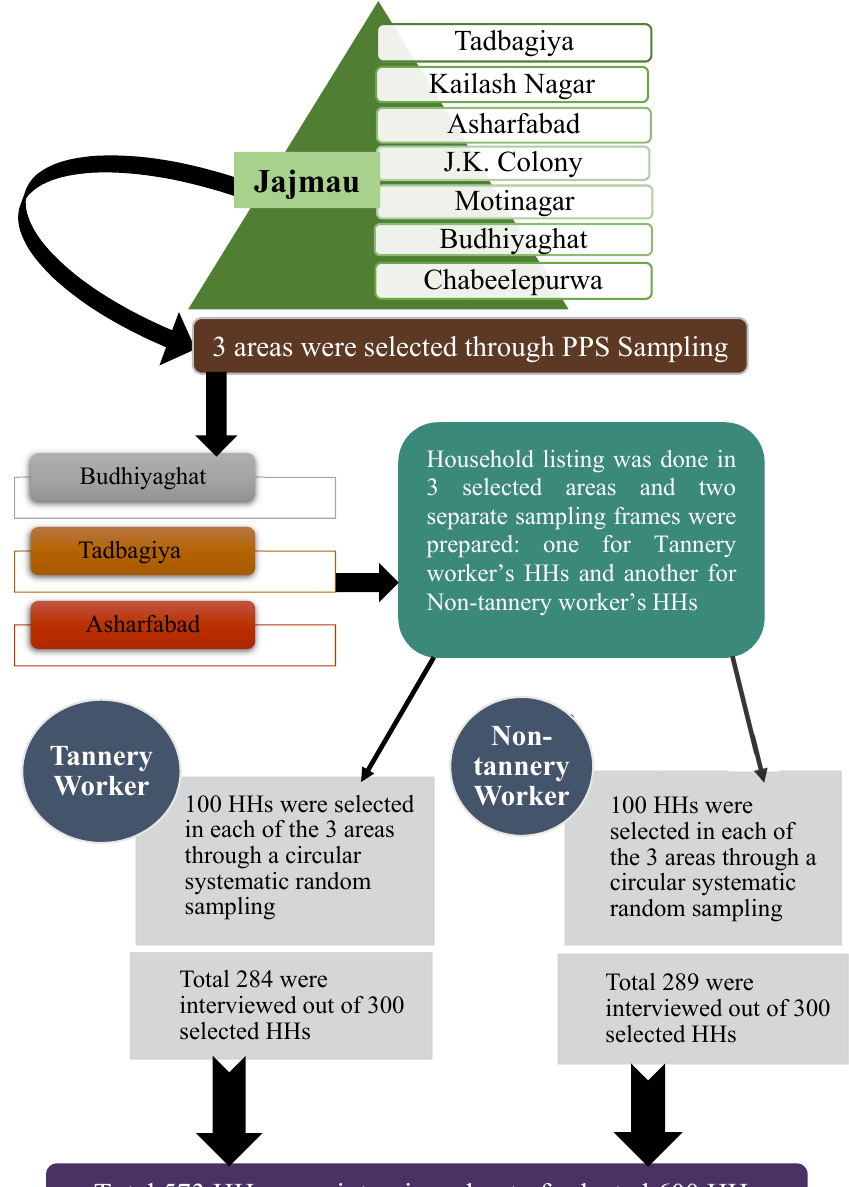
Figure 2: Sampling design for the study 118